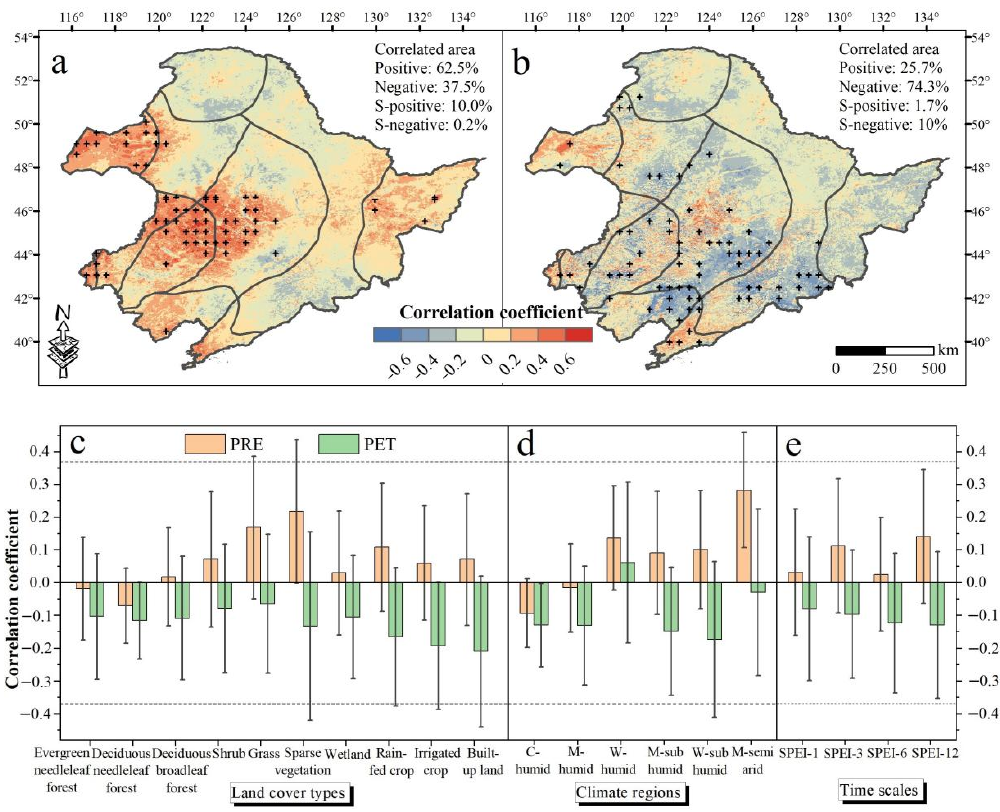
Figure 6. Spatial distribution of the partial correlations between precipitation (PRE) and NDVI ( a ), and between potential evapotranspiration (PET) and NDVI ( b ); the statistical distributions of the partial correlations for different land cover types ( c ), climate regions ( d ), and time scales ( e ) (i.e., the area corresponding to the time scale with the largest absolute value of the correlation coefficient between NDVI and multi time scales SPEI. S- in ( a , b ) are the abbreviation for significant. Black crosses indicate significant partial correlations with p < 0.05. The data in ( c – e ) are the means ± standard deviations. The dotted lines in ( c – e ) indicates significant Pearson correlations with p < 0.05.